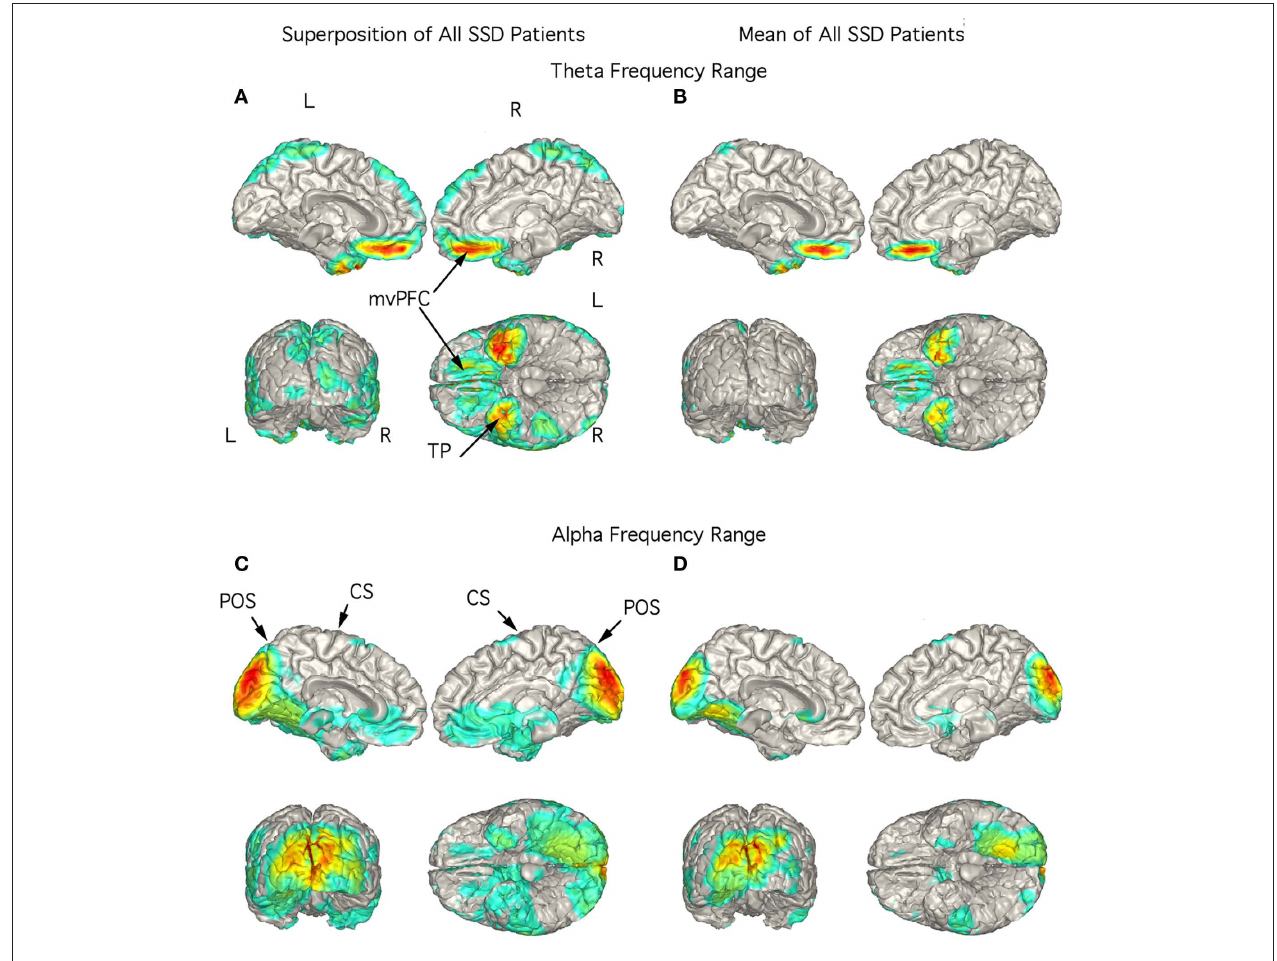
FiGure 3 | Localization of theta and alpha band current sources in SSD patients. (A) Superposition of theta range independent components (ICs) for SSD patients. Note that activity is to bilateral medial ventral pre-frontal cortex (mvPFC) and bilateral temporal pole (TP). (B) Mean of localizations shown in (A) .